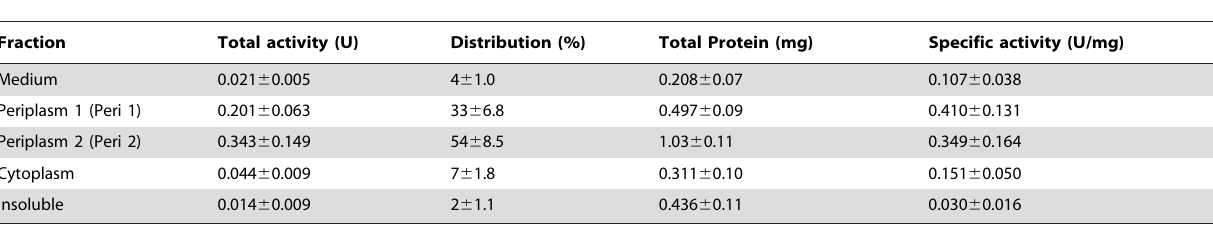
Table 1. Subcellular distribution of chitinolytic activity in E. coli.